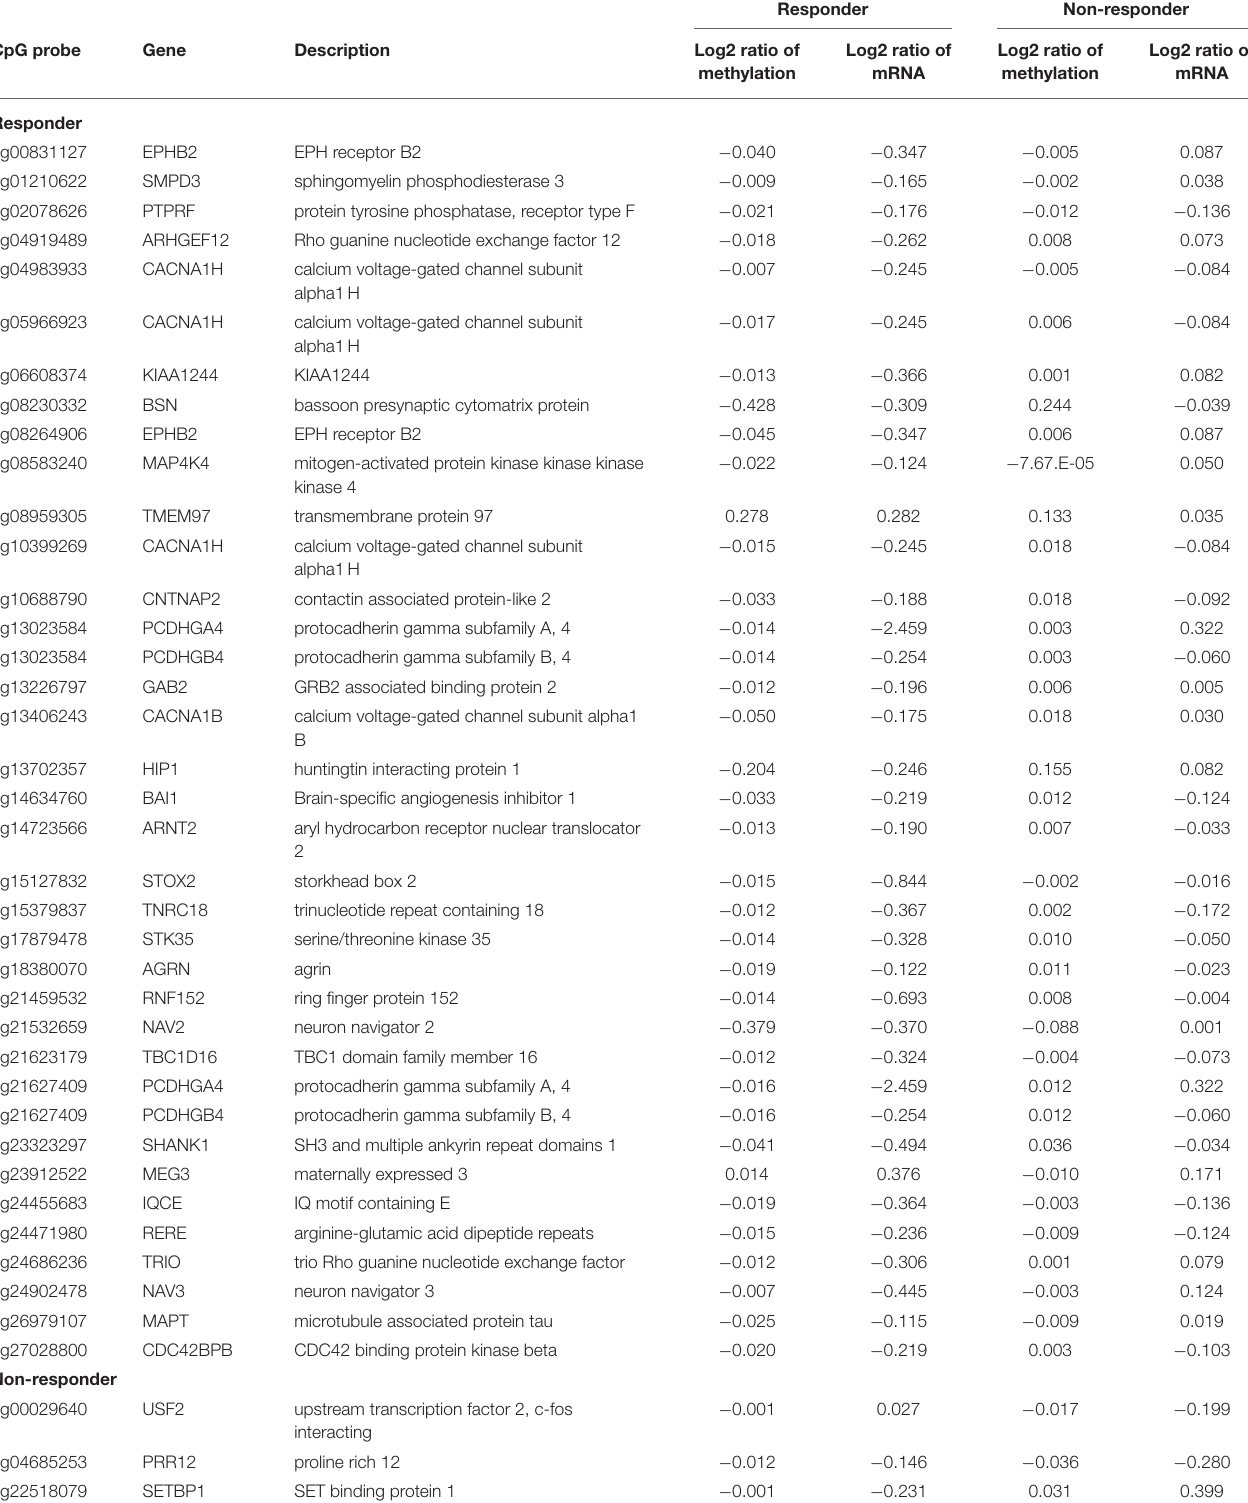
TABLE 2 | Genes changed in the same direction as the gene body CpG sites in response to